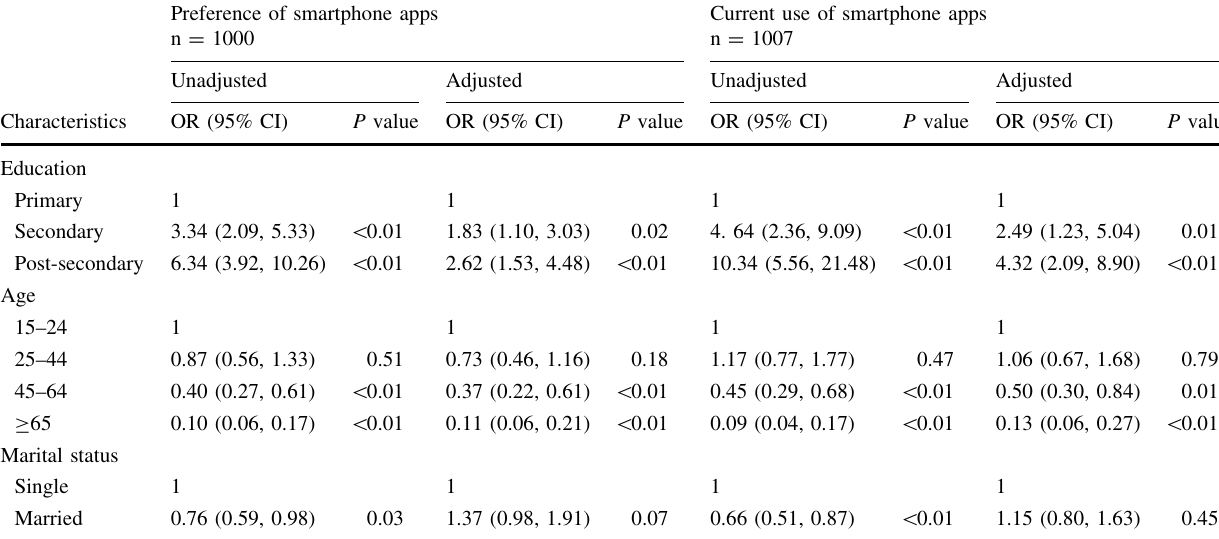
Table 2 Simple and multiple logistic regression analyses of the key demographics towards the use of smartphone apps for weather information acquisition in Hong Kong in January/February 2016